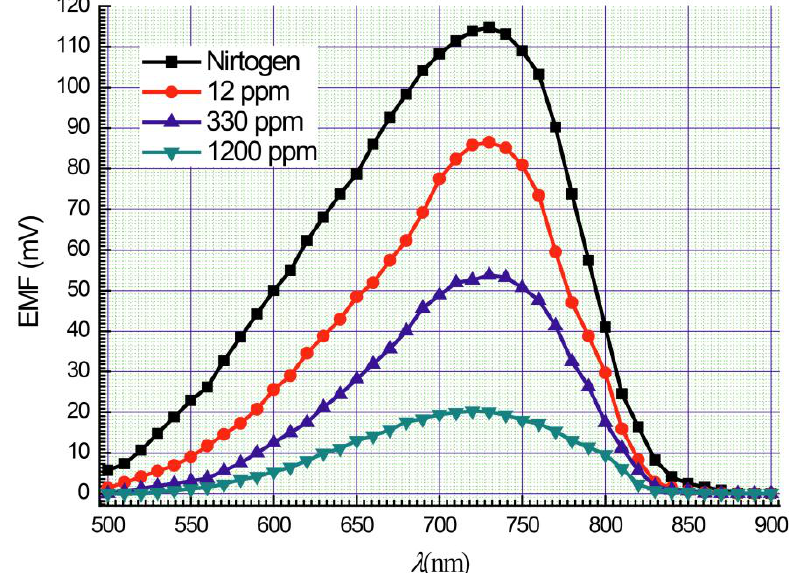
Figure 2. Spectral dependences of Photo-EMF on nitrogen and on different ammonia